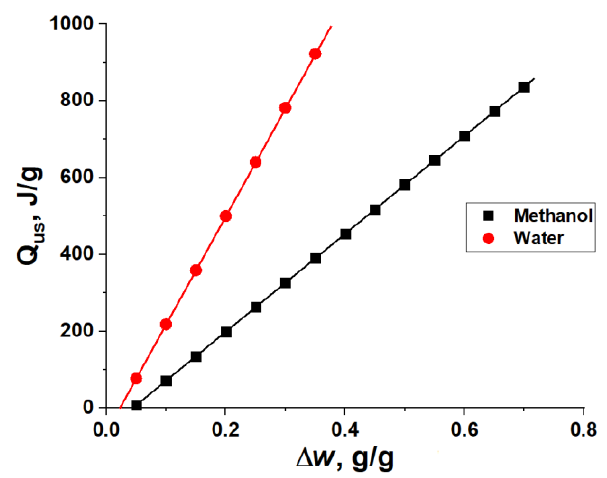
Figure 2. Useful heat for water and methanol as adsorptive and LiCl / (silica gel) as adsorbent (see details in the text).